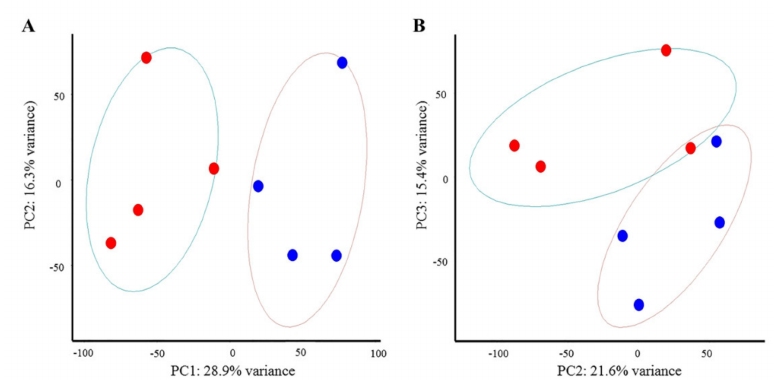
Figure 2. Principal component analysis (PCA) plots generated with ggbiplot in R showing variation and separation of samples between di ff erent treatments. ( A ) PCA plot for samples at 2 days post inoculation(dpi). ( B )PCAplotforsamplesat6dpi. Sampleindi ff erenttreatmentsareseparatedbyaline.